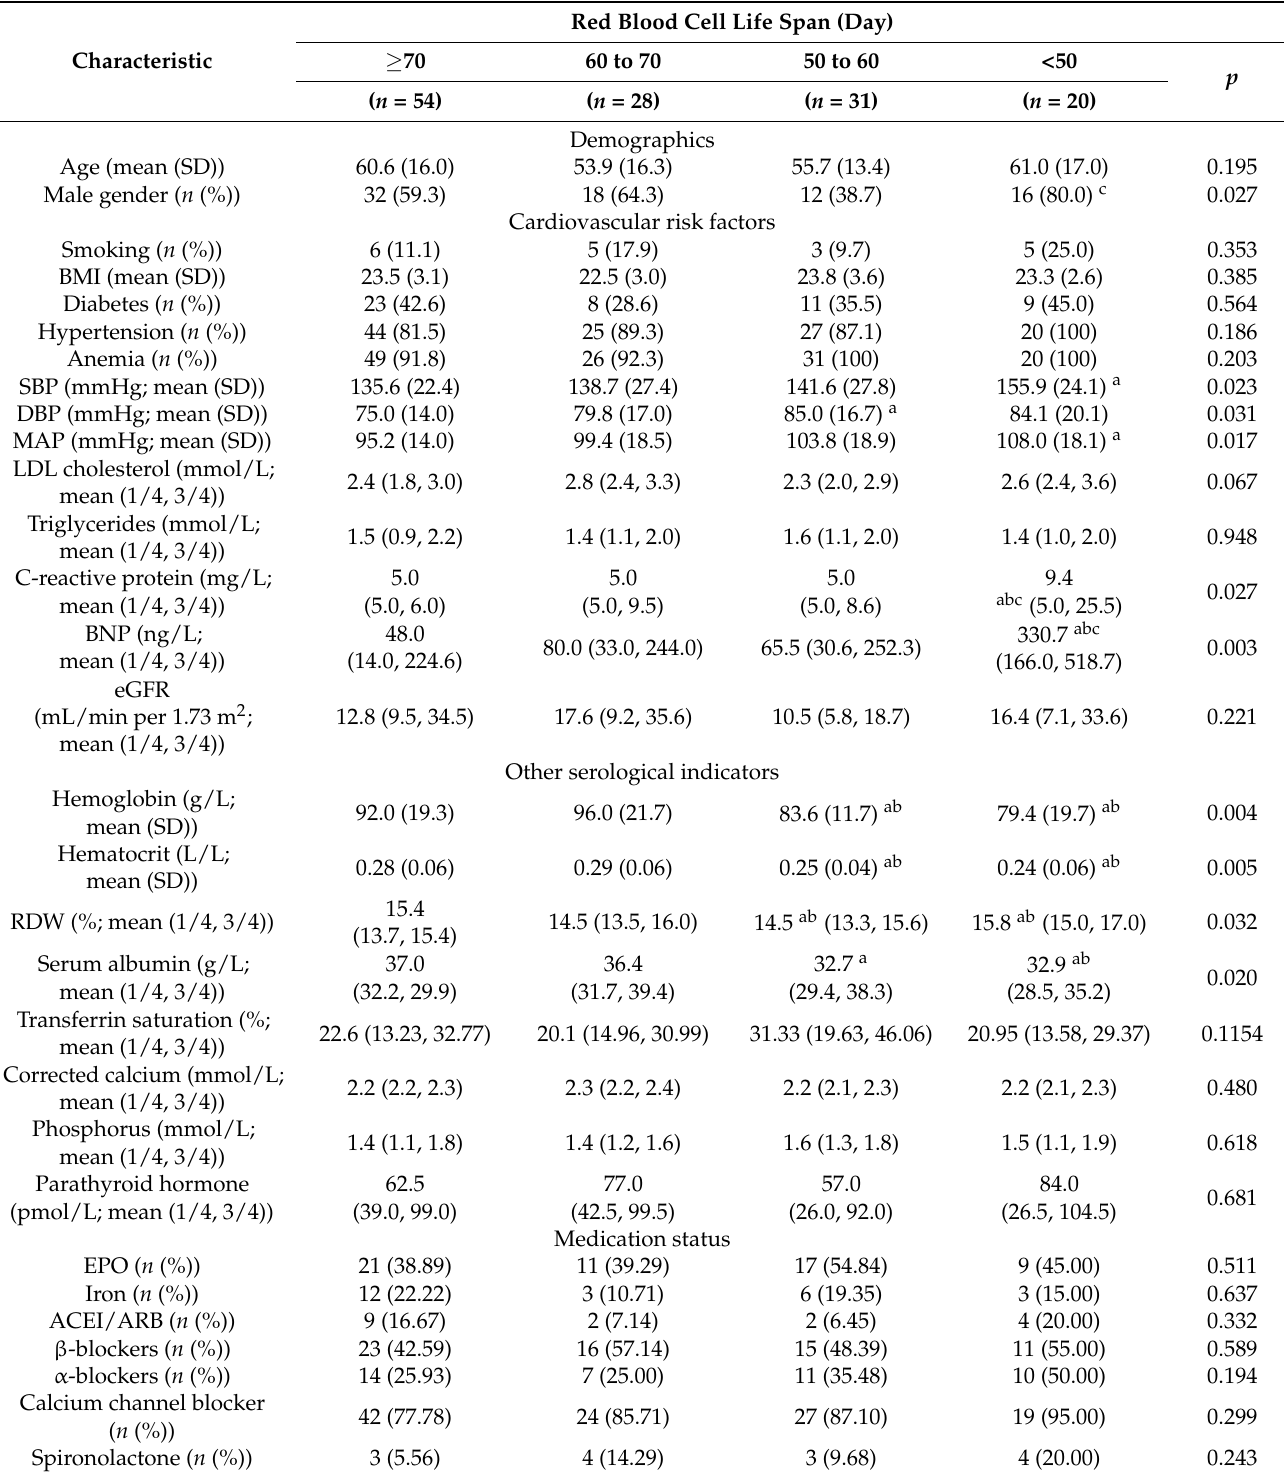
Table 1. Comparison of general data in non-dialysis patients with CKD stages 3–5 with shortened